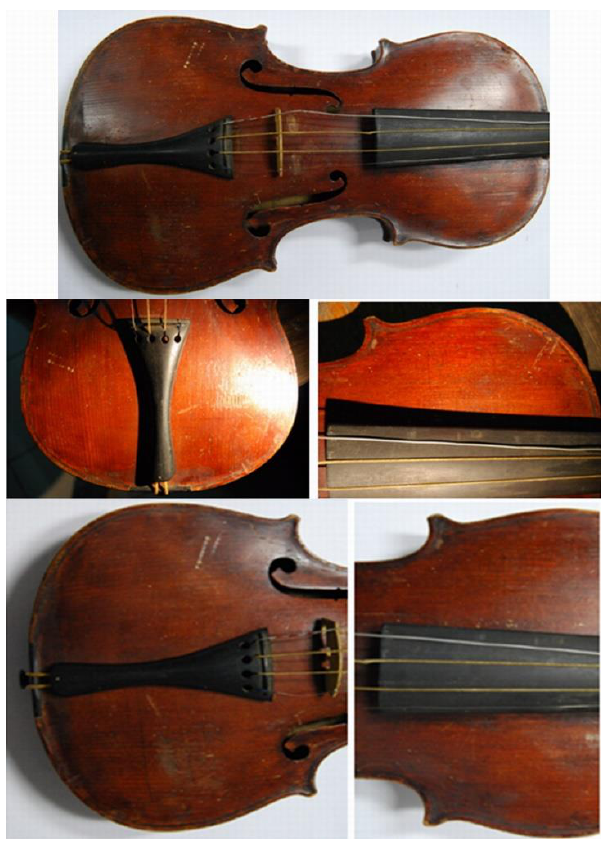
Figure 5. Details with damage and degradation of the top cover.